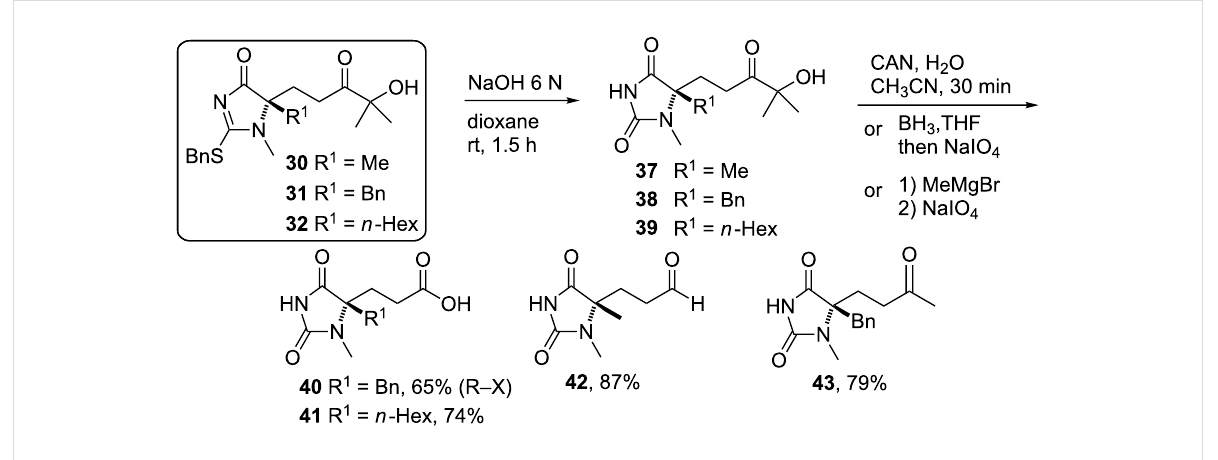
Scheme 6: Elaboration of the Michael adducts coming from the Michael addition to nitroolefins